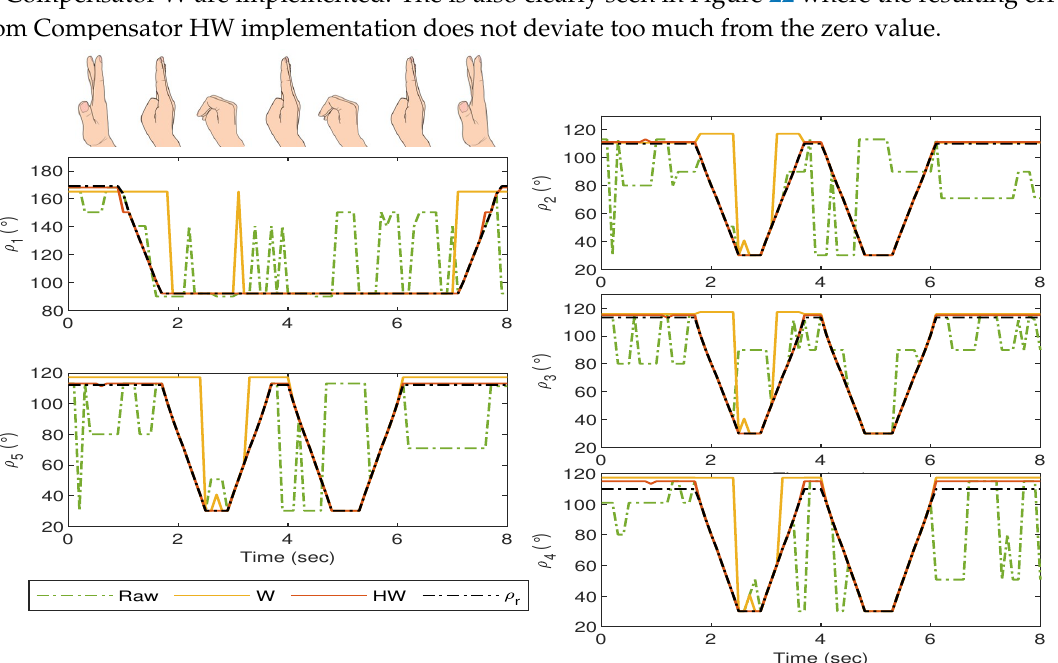
Figure 21. Gesture 5: The mismatch between the glove’s and bionic hand’s goniometry is minimal when Compensator HW is applied as compared to the